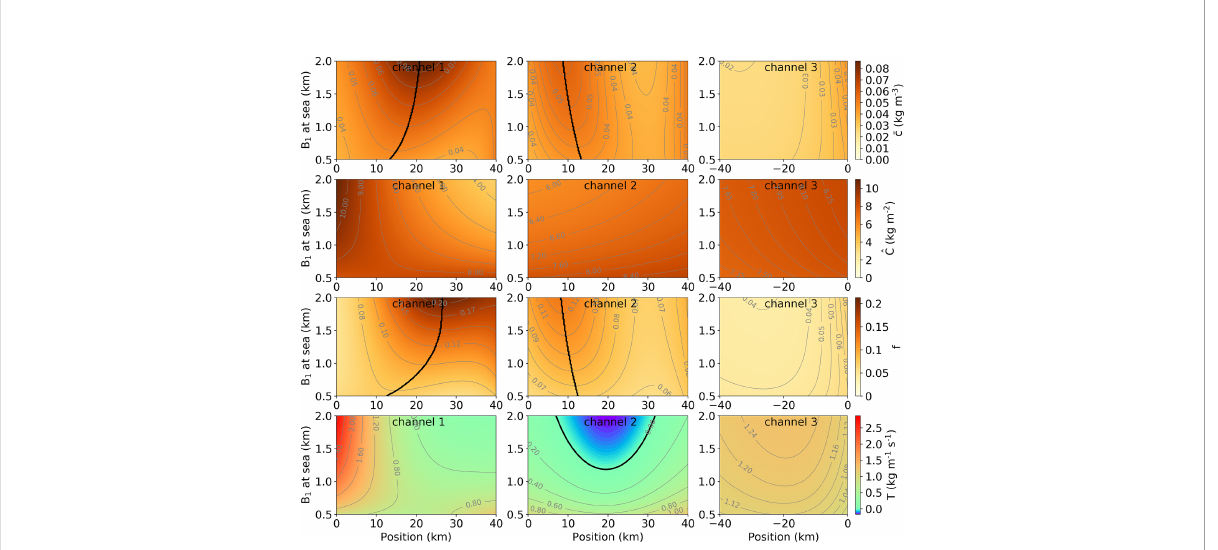
FIGURE 12 Sensitivity of along-channel distribution of depth-averaged subtidal concentration ( fi rst row), transport capacity p.u. width (second row), availability (third row), and carrying capacity (fourth row) to the width of Channel 1 at the